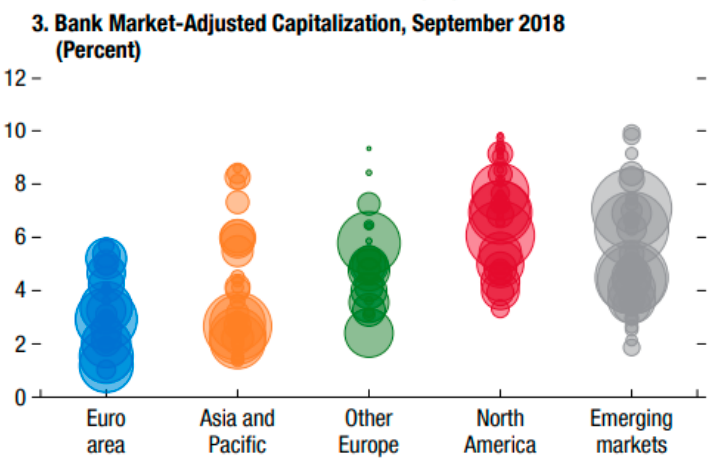
Figure 2. Bank market-adjusted capitalization, September 2018.